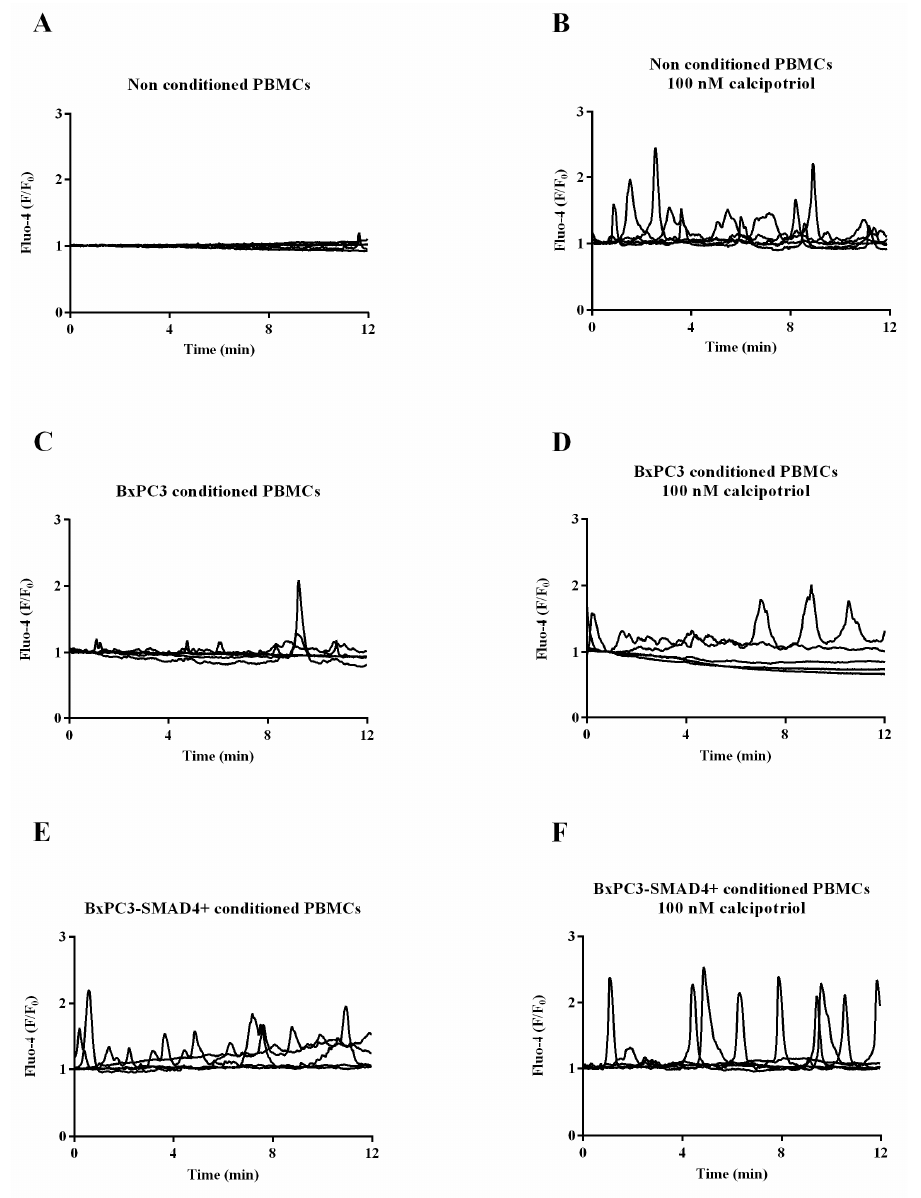
Figure 1. Intracellular calcium fluxes ([Ca 2+ ] i ) of PBMCs cultured or not with BxPC3 or BxPC3- SMAD4+ conditioned media in the presence or in the absence of 100 nM calcipotriol.